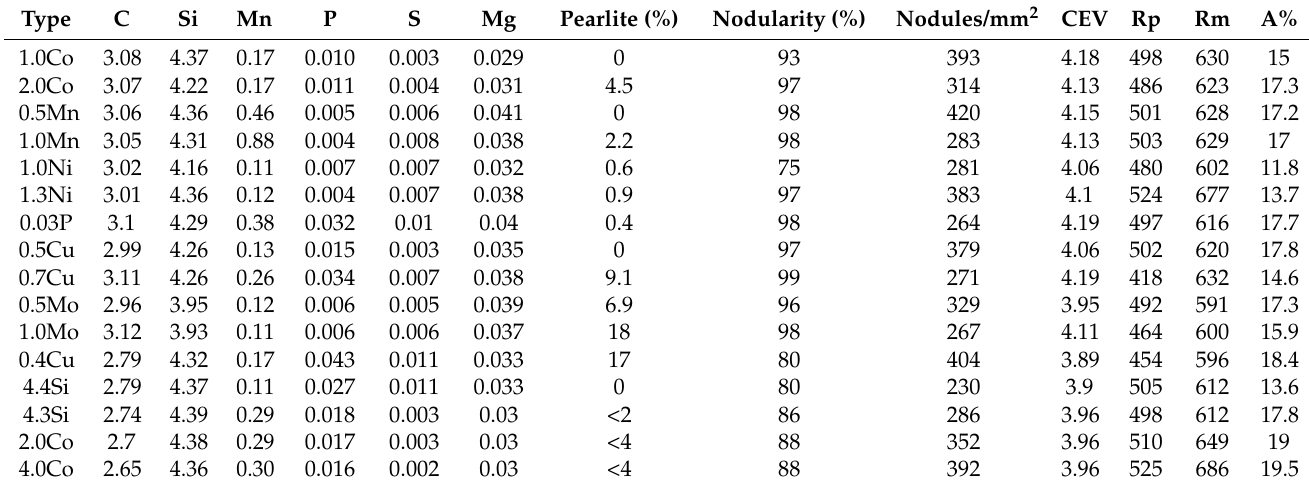
Table 5. Summary of alloying trails on EN-GJS-600-10. Adapted from